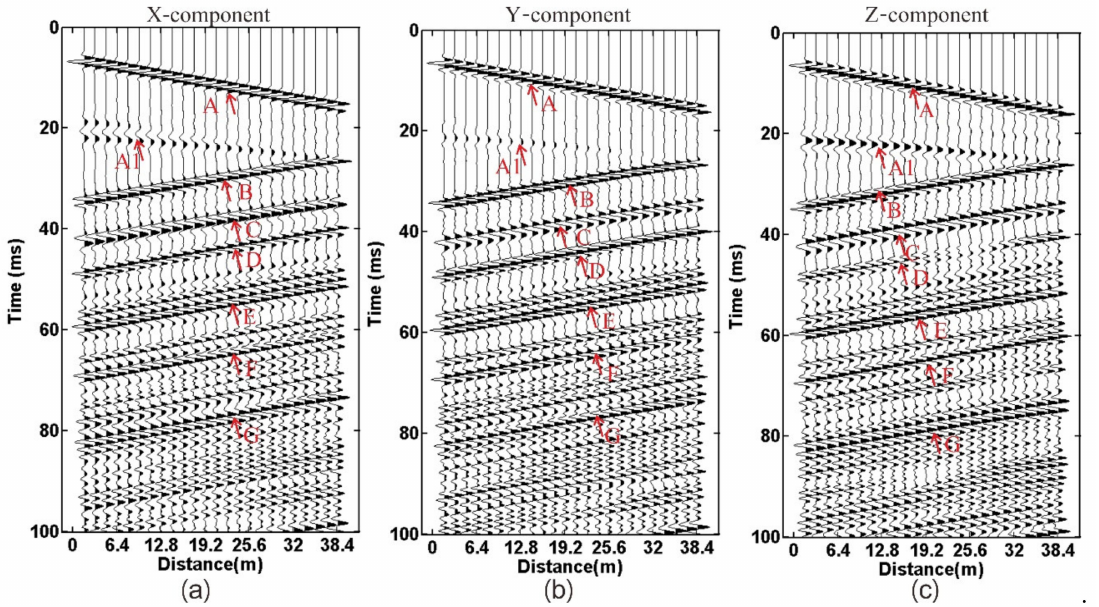
Figure 5. Wavefield recording: ( a ) X-component; ( b ) Y-component; ( c ) Z-component. The symbol A denotes the direct wave, A1 the reflection wave from the tunnel top interface, B to D the reflection wave from the karst cave, E and F the reflection wave from the interlayer, G the multiple